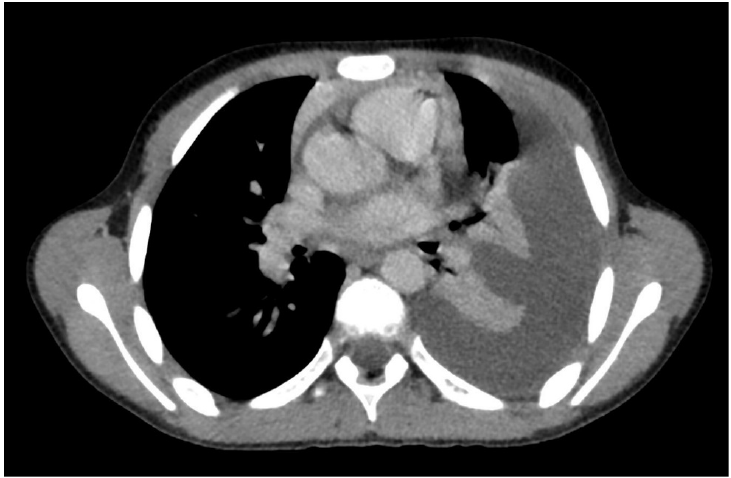
Figure 9. Pleural effusion of the left lung with associated pulmonary atelectasis in a 10-year-old